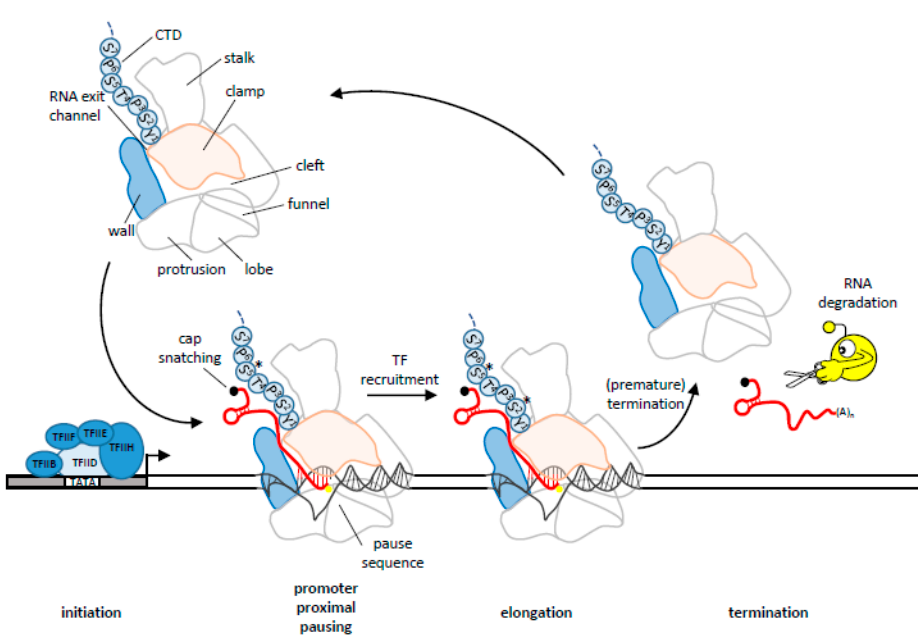
Figure 1. Transcription cycle. A cartoon depiction of RNA polymerase II (RNAPII) is shown in the upper left, with several domains and modules labelled. The clamp and wall (flap in prokaryotes) modules that make up the RNA-exit channel are depicted in pink and blue, respectively. The first repeat of the RNAPII C-terminal domain (CTD) is shown as a string of amino acids with their respective numbers. Next, the stages of the transcription cycle are shown, with the viral interfering mechanisms. First, general transcription factors assemble at the promoter and direct RNAPII towards the transcription start site. Transcription factor (TF) IIH phosphorylates the RNAPII at Ser5 (black asterisk). TFIIH opens the DNA template, forming the transcription bubble, permitting RNAPII to begin transcribing RNA in its active center (yellow dot). Upon transcribing the first 20–60 nucleotides, most RNAP will pause. Transcription factor recruitment regulates these transcription kinetics and phosphorylate RNAPII at Ser2. When the correct signal is encountered, RNAPII will terminate transcription and release the RNA. Some viruses encode endonucleases (yellow sphere with scissor) that can cleave RNAs, causing RNA degradation.